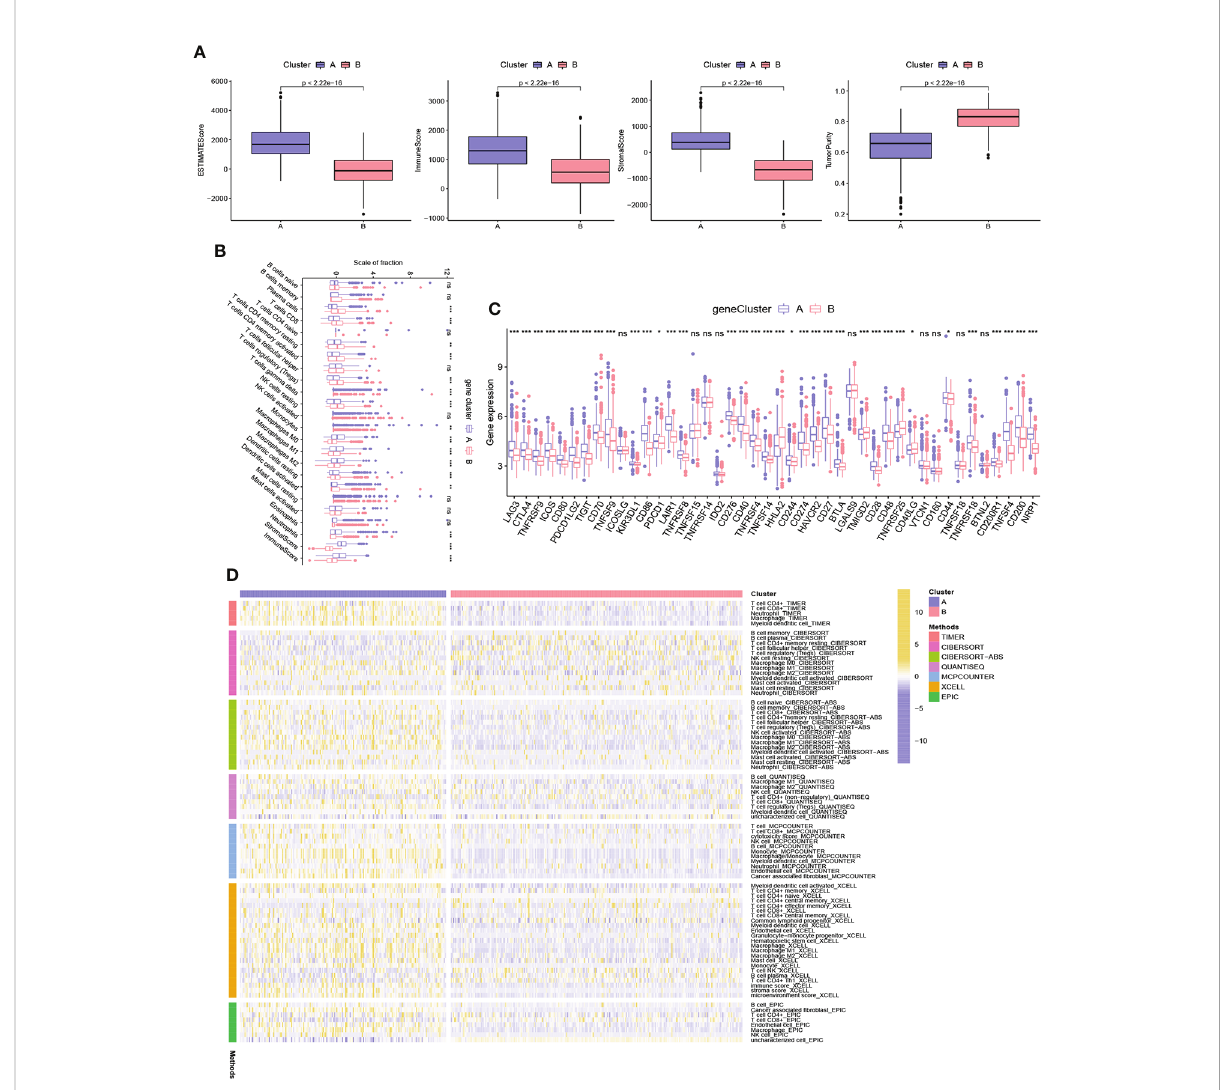
FIGURE 4 Characteristics of TME between different gene subtypes. (A) Estimate scores, stromal scores, immune scores, and tumor purity of two gene subtypes. (B) TME immune-in fi ltrating characteristics and transcriptome traits of two gene clusters. (C) Different expression of immune checkpoint genes in distinct gene clusters. (D) Heatmap showing differences in immune-in fi ltrating characteristics between two gene clusters of TCGA samples based on multiple algorithms. ***P < 0.001; **P < 0.01; *P < 0.05; ns P ≥